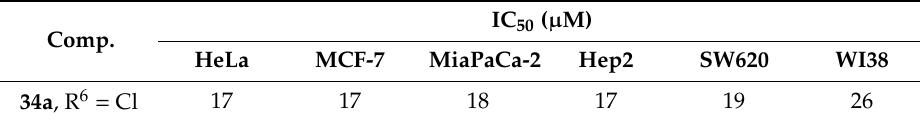
Table 10. The cytostatic effects of the 6-chloro-2,3-di- O -benzyl- L -ASA derivative 34a . Comp.